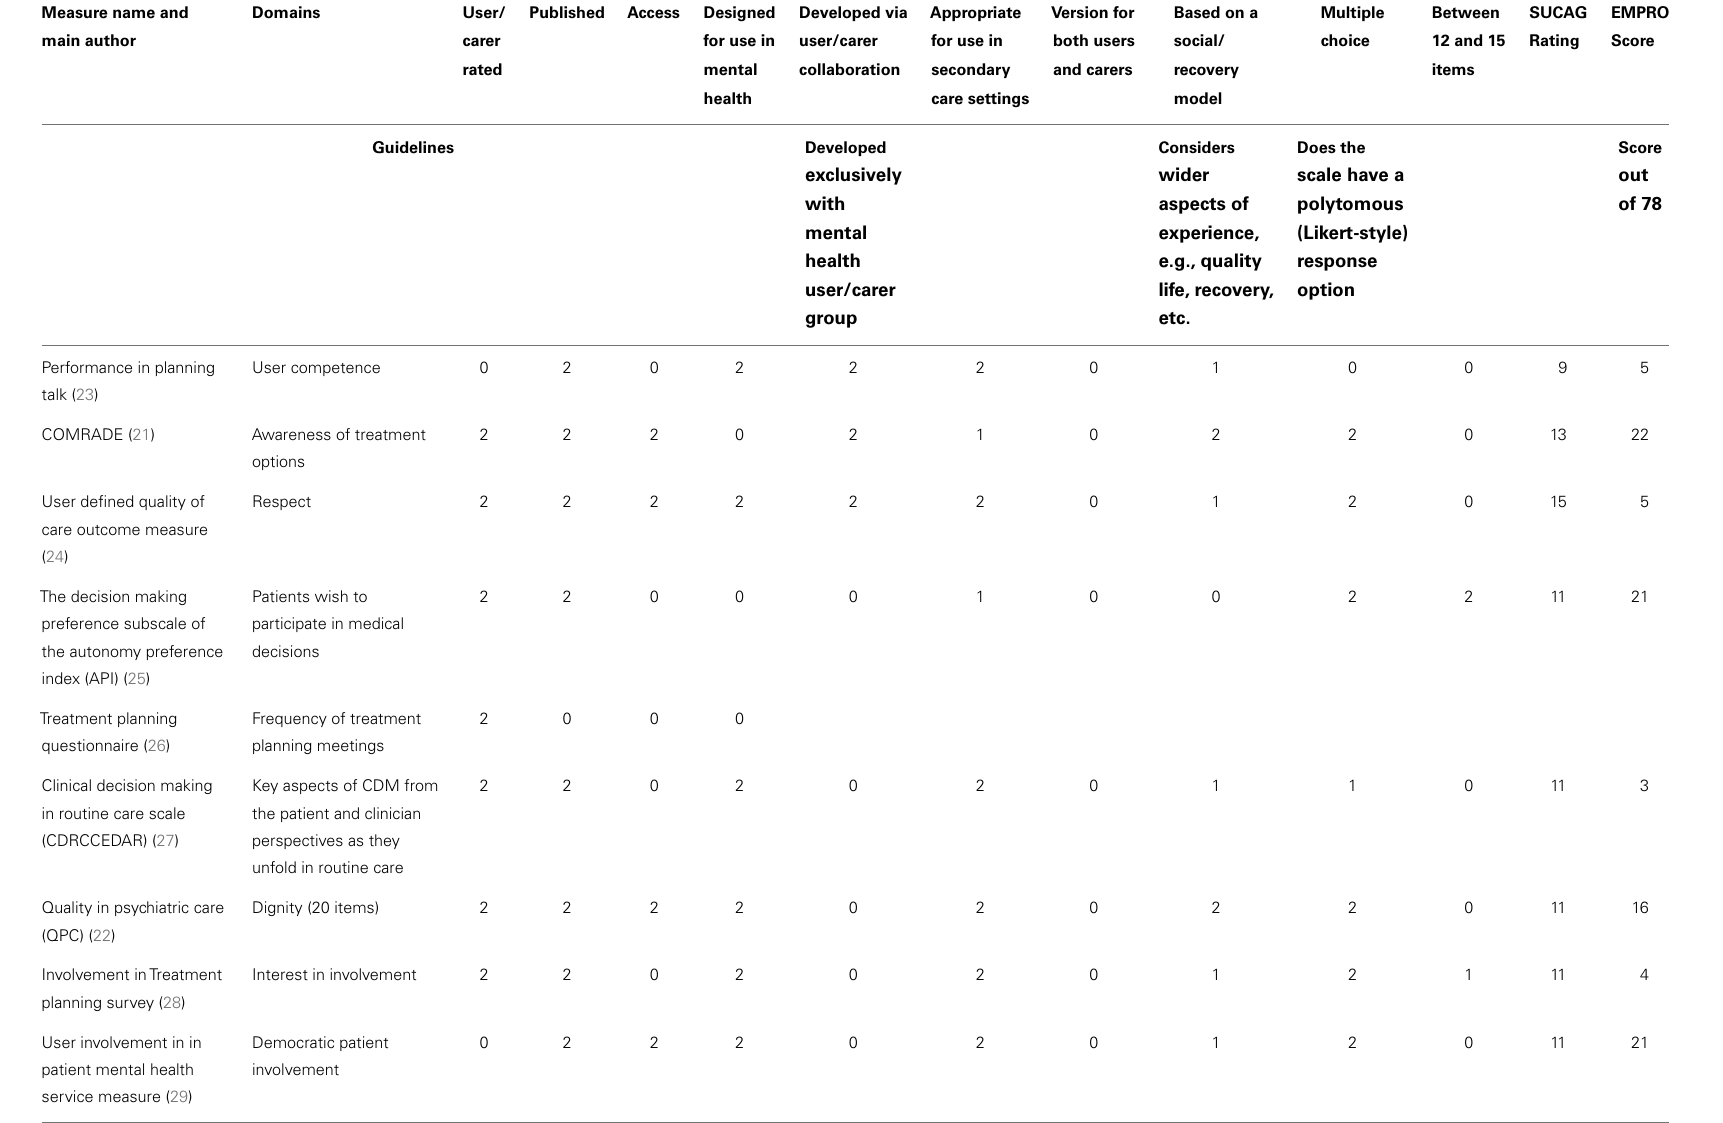
Table 1 | Summary of included questionnaire measures